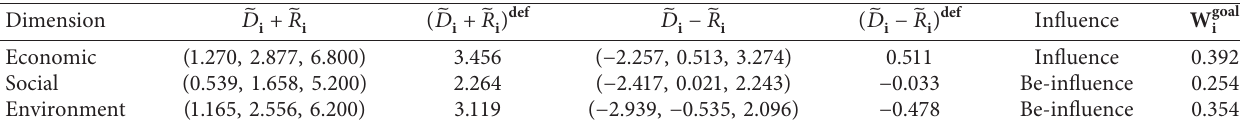
Table 37: Importance weight of sustainability dimensions in fuzzy condition.